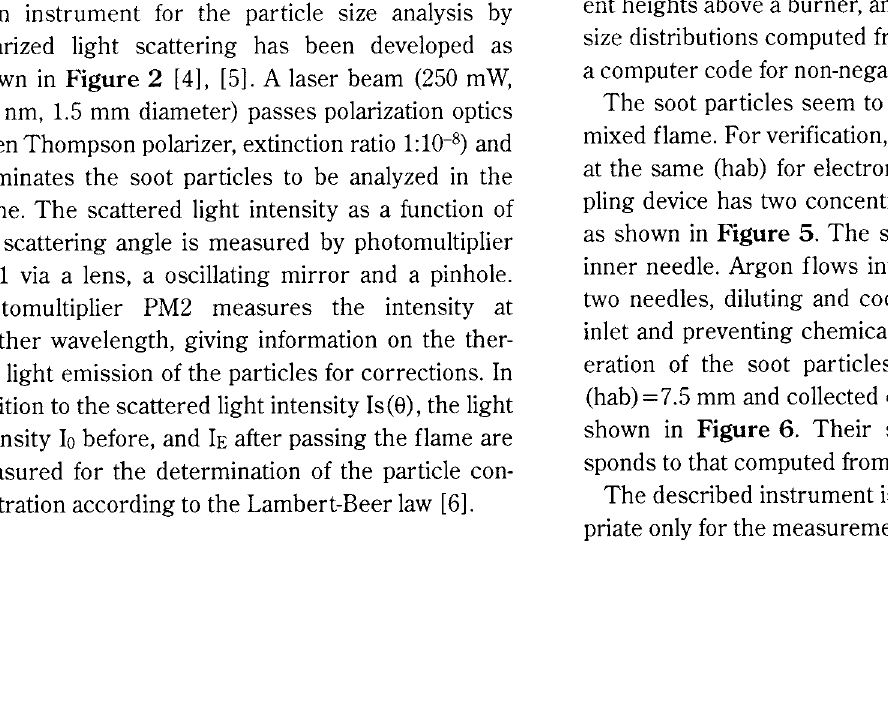
Experimental setup for the determination of size distribu tions of soot particles in a premixed